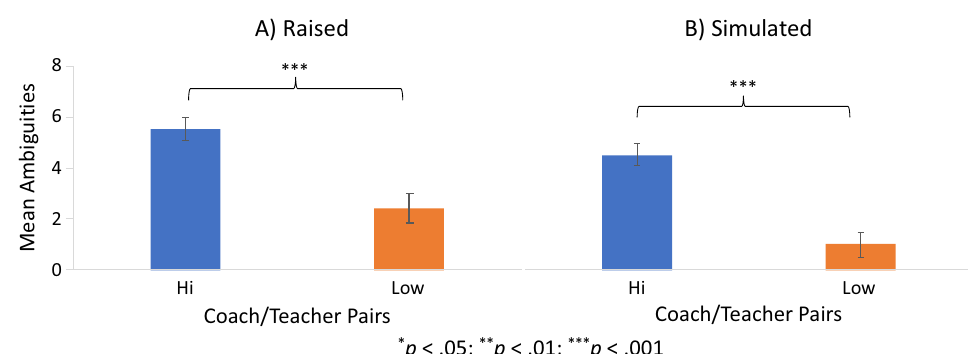
Fig. 3 The mean number (with SE bars) per coach–teacher conference by high- vs. low-growth pairs (along with statistical significance of the group contrast) of A all Ambiguities, and B all Ambiguities that are raised and then